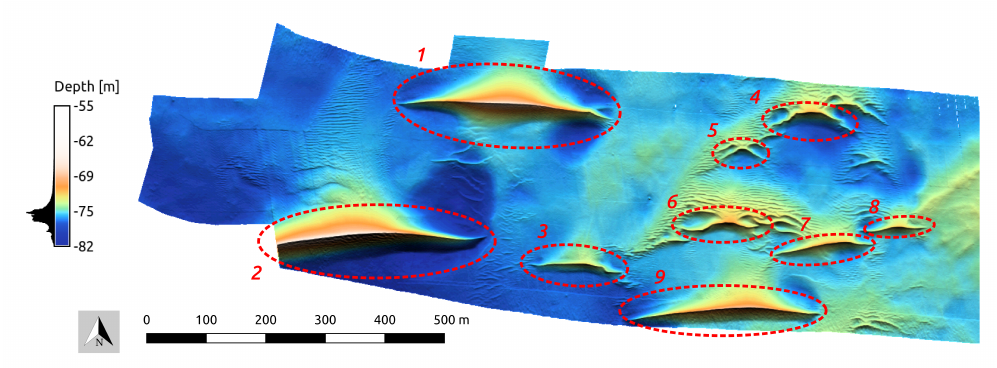
Figure 5. Areas numbered 1–9 indicate visually identified sand waves with height ≥ 2 m, used as control features for the selection of model outputs.